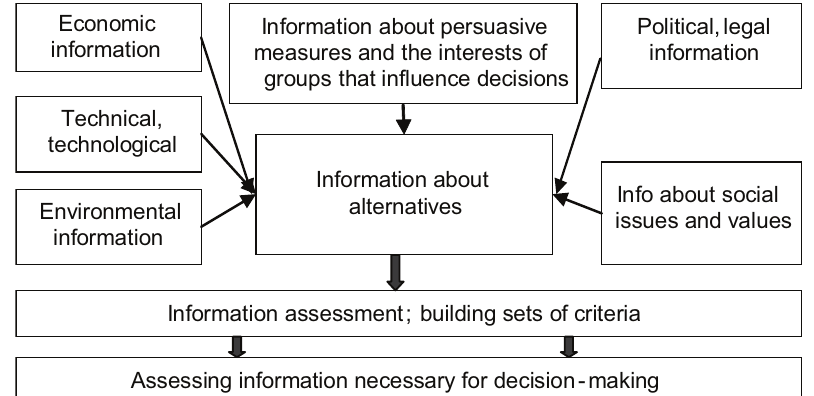
Figure 1. the information model for preparation of decisions